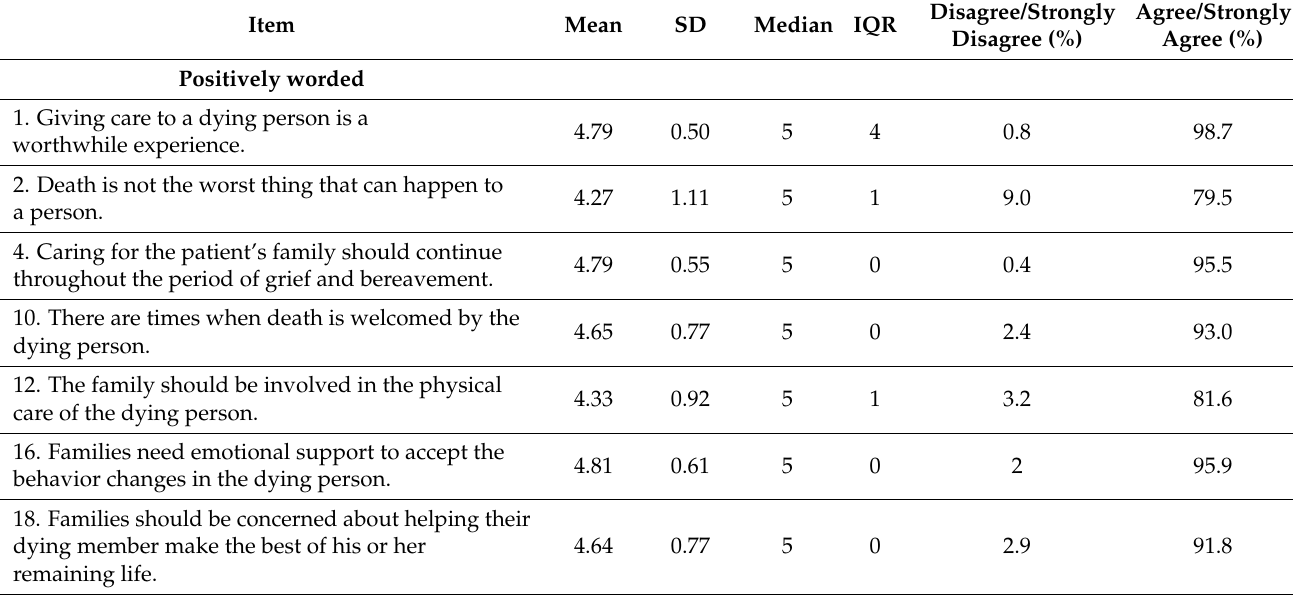
Table 4. Answers based on each item of